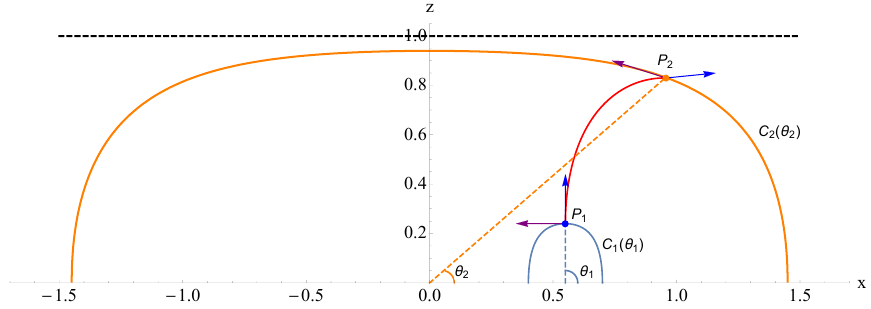
Figure 6 . The illustration of the numerical algorithm for